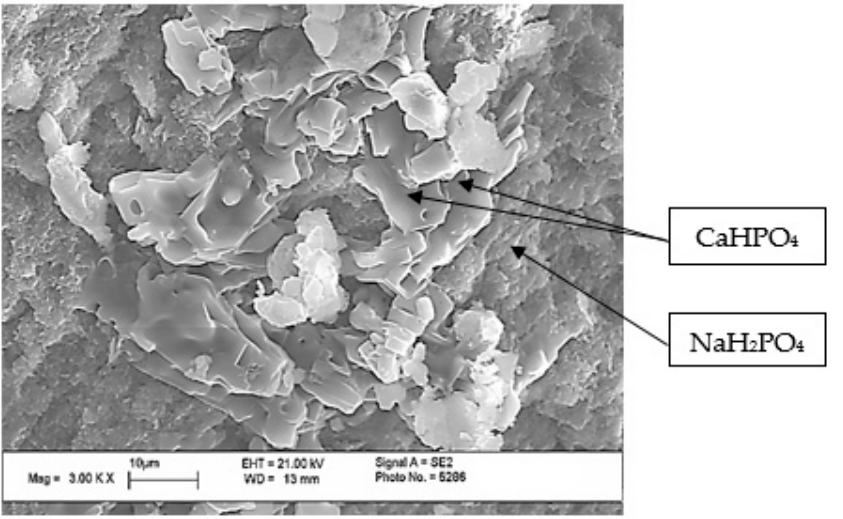
Figure 2. The SEM image of cement-salt stone based on calcium citrate tetrahydrate and sodium dihydrogen phosphate.